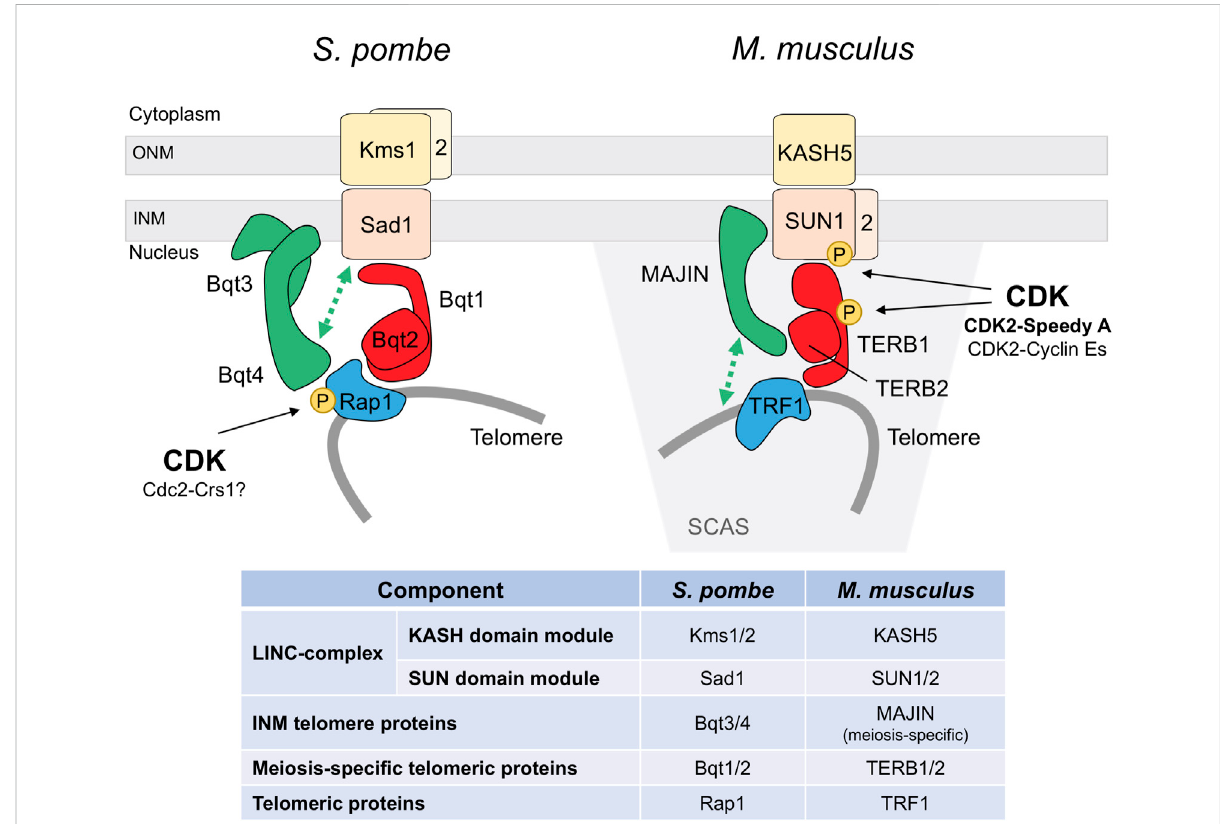
FIGURE 2 CDKregulationofthemeiotictelomereattachmenttothenuclearenvelope. S.pombe and M.musculus models.Functionalconservationofthe different elements is highlighted by the same color. INM inner nuclear membrane, ONM outer nuclear membrane, SCAS synaptonemal complex attachment sites. Protein interactions are based on Chikashige et al., 2006, Chikashige et al., 2009, and Hu et al., 2019 for fi ssion yeast, and Shibuya et al., 2014, Shibuya et al., 2015, and Wang et al., 2020 for